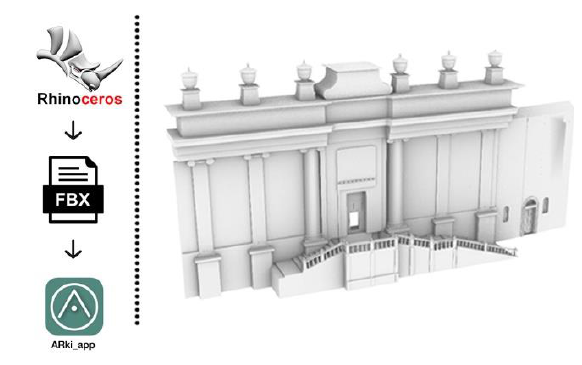
Figure 11. NURBS model, in Rhinoceros.